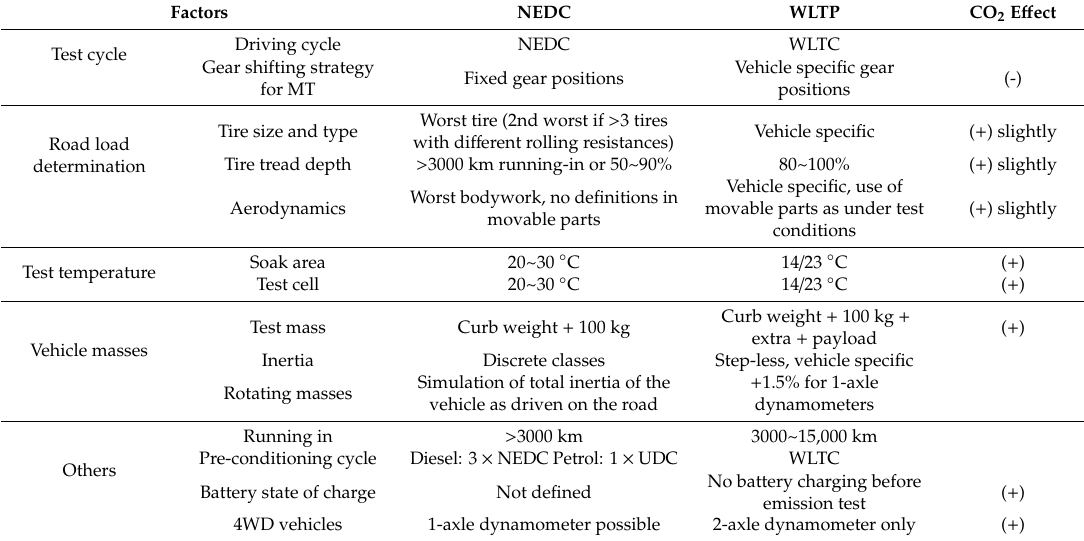
Table 1. Parameters with potential impact on CO 2 emissions with di ff erent definitions in NEDC and WLTP [5].